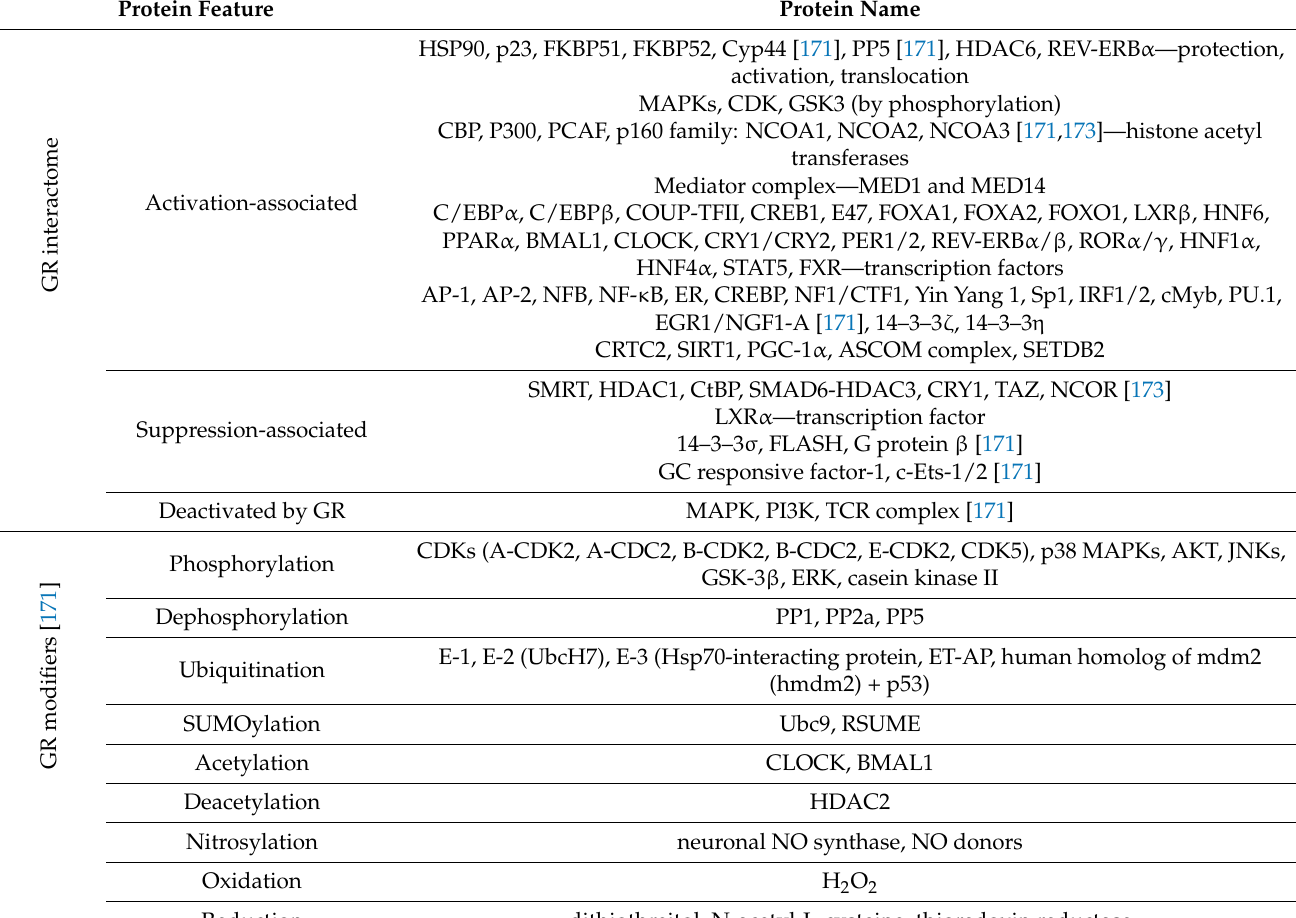
Table 4. Sample elements of GR interactome and the modifications of the GR